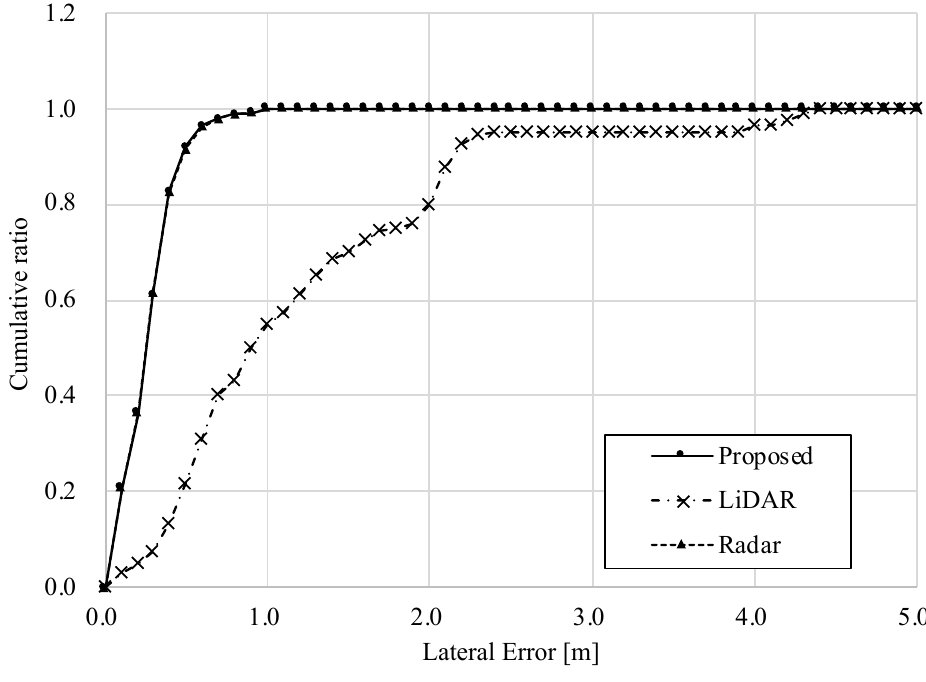
Figure 17. Lateral error in snow-covered road surface